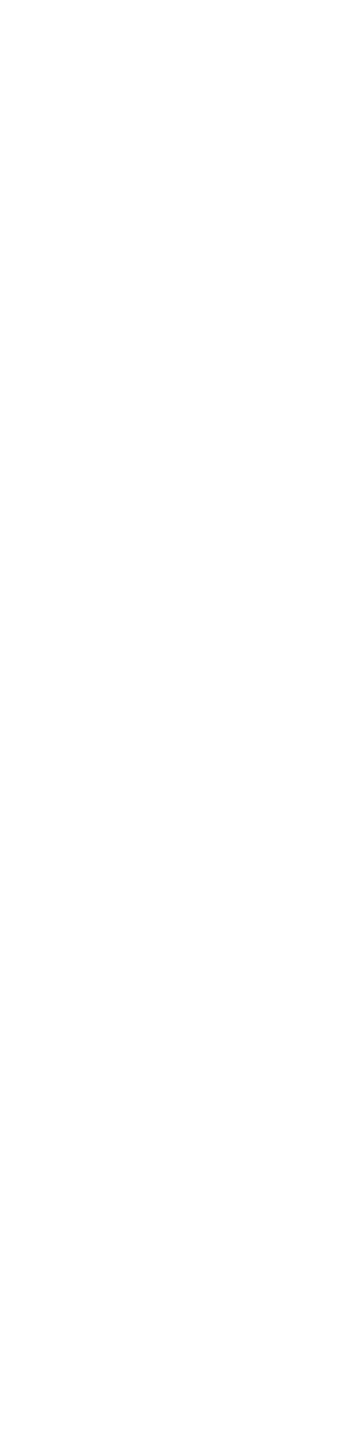
FIGURE 7 (A) Anomalies of seabird reproduction through time, (B) relationship between common murre reproduction and eagle disturbance (reproduction anomaly ~ − 1.16 * disturbance anomaly + 2.561e − 10; adjusted R 2 = 0.56, p < 0.001), and (C) common murre diet through time at Yaquina Head and (D) seabird reproduction and (E) common murre diet at Southeast Farallon